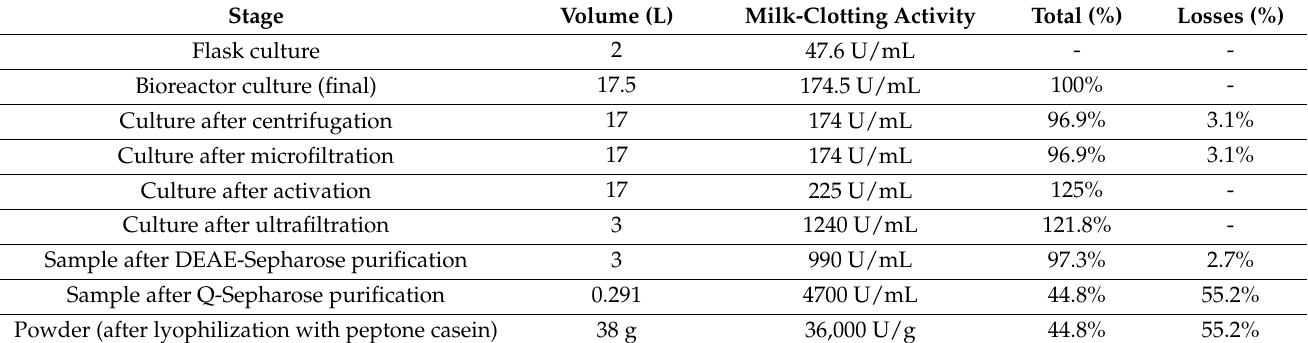
Table 1. Data on enzymatic activity at all stages of preparation of the BacChym.